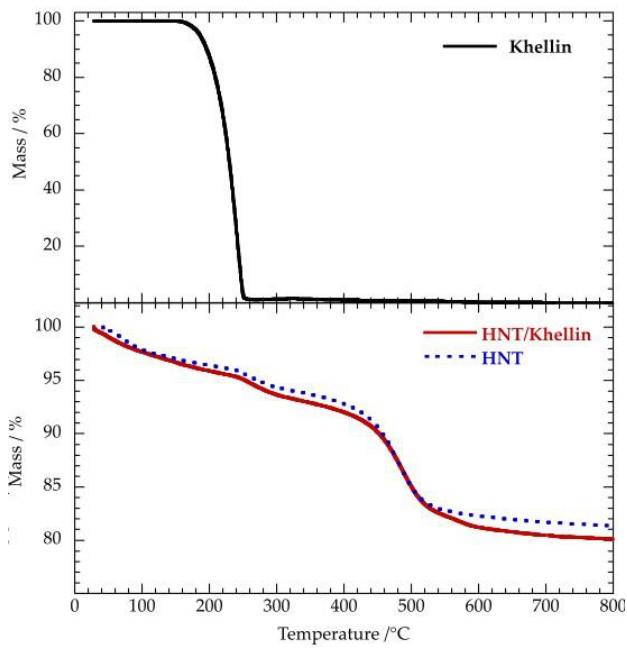
Figure 2. Thermogravimetric curves for Khellin, HNT and HNT / Khellin.